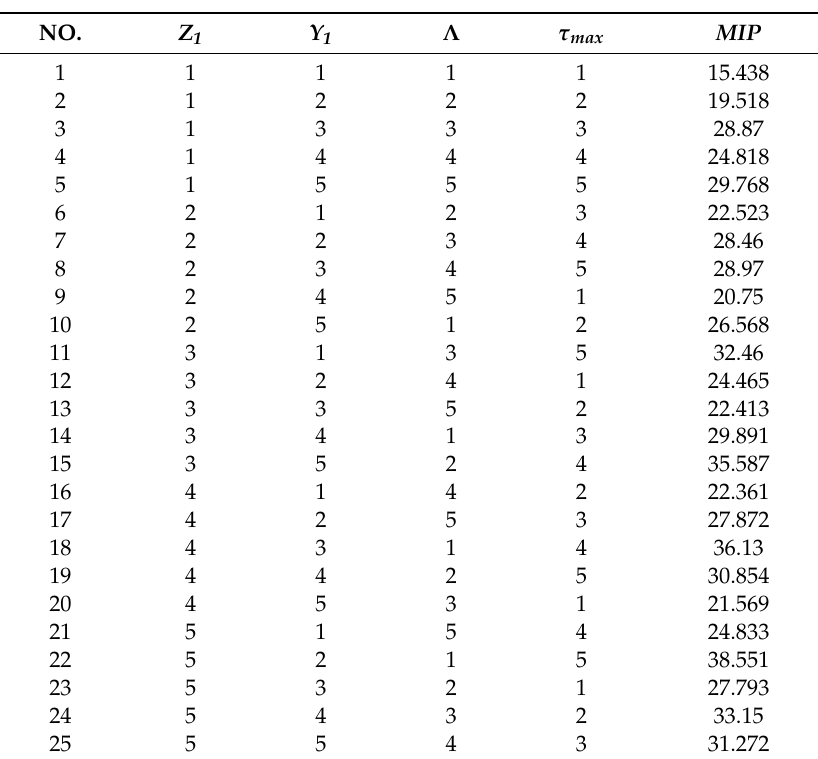
Table A8. GA parameters orthogonal experiment